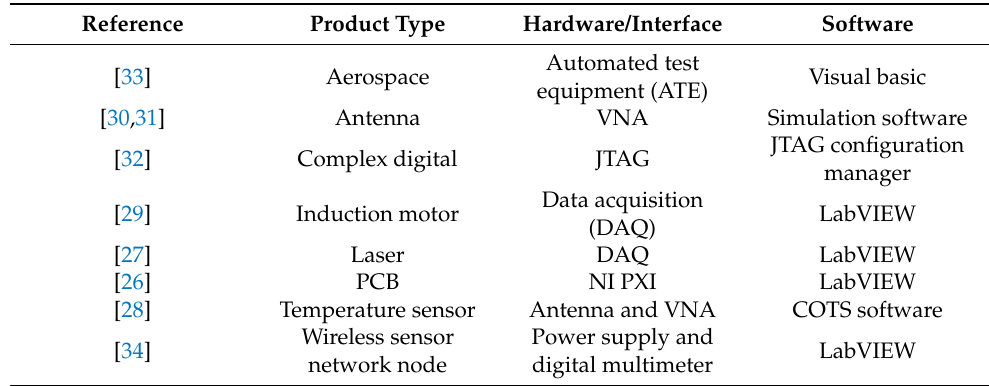
Table 2. Summary of some existing test